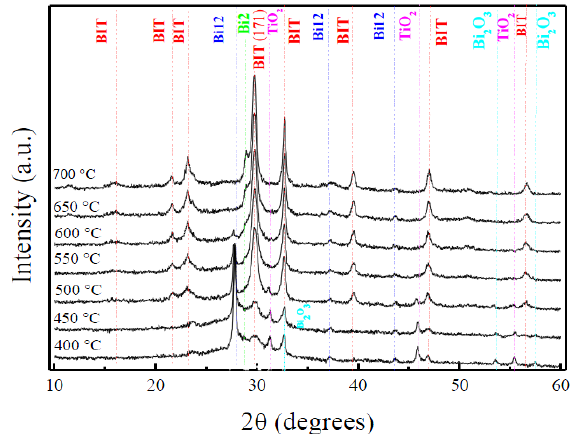
Ti O phases: Bi x y z